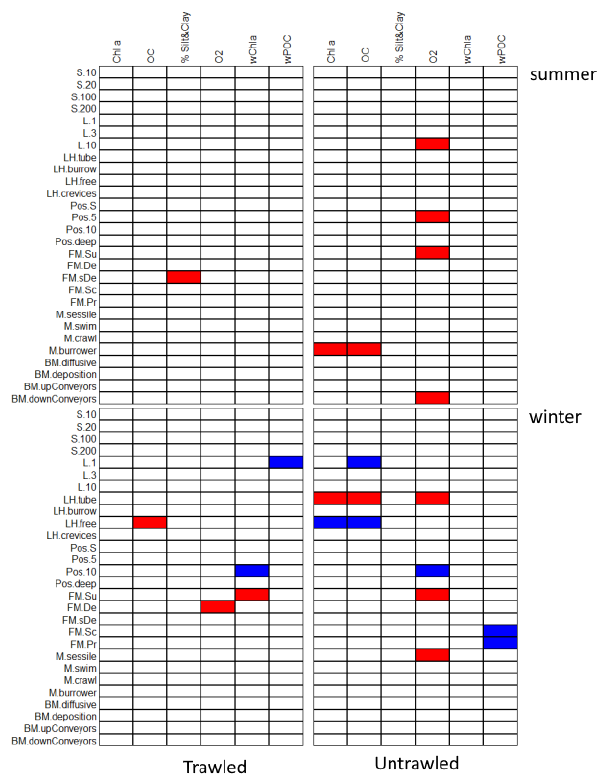
Figure 5. Representation of significant ( p < 0.05) associations identified by the fourth-corner method. The blue shades indicate significant positive associations and red shades significant negative associ- ations between traits and biogeochemical variables. Variables with no significant associations are shown in white. p values were adjusted for multiple comparisons using the FDR procedure. Codes for traits are explained in Table 1. Chla: chlorophyll a, OC: organic carbon, %Silt&Clay: silt and clay percentage, O 2 : oxygen, wChla: water column chlorophyll, wPOC: particulate organic carbon.